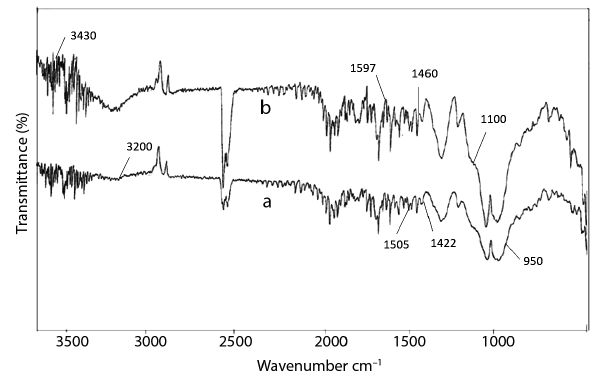
Figure 12 represents the FTIR spectra of Cu(II) loaded and fresh coconut shells. The band shifted around the peak 3430 cm –1 shows the involvement of –OH group.